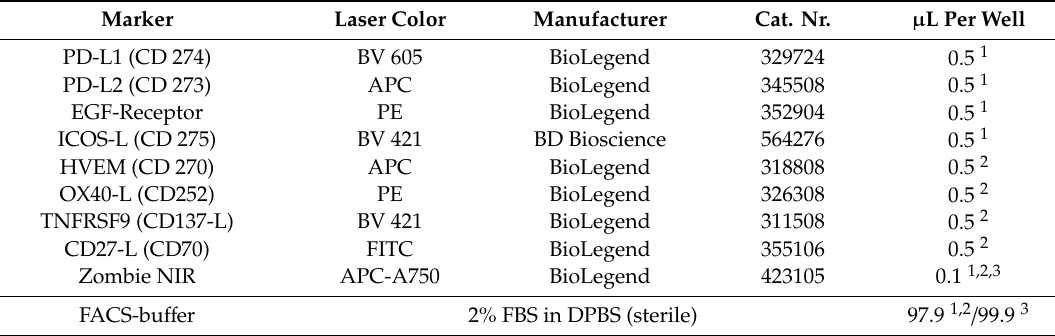
Figure 7. Immunological synapse between an antigen-presenting cell or a tumor cell and a T cell. Both, immune suppressive ( − ) and immune stimulatory ( + ) checkpoint molecules are present. Table 1. Antibodies used for the analyses of the surface expression of immune checkpoint molecules and of EGFR by multicolor flow cytometry.